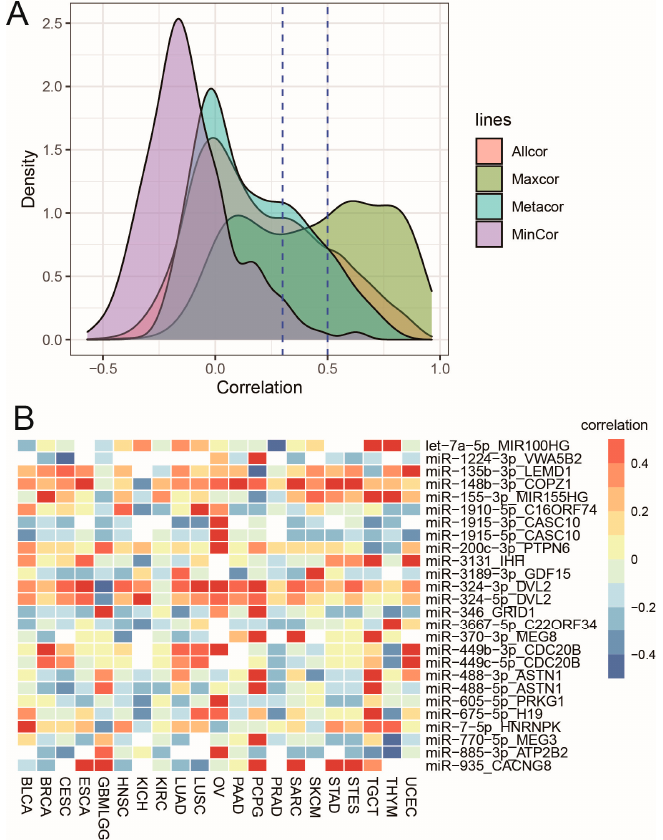
Figure 3. Cancer-specific co-transcriptional patterns between miRNA and host genes. ( A ). The distribution of expression correlations between miRNAs and their hosts. ( B ). The miRNA-host pairs whose maximum correlation >0.5 and minimum correlation < − 0.3 across cancer types.